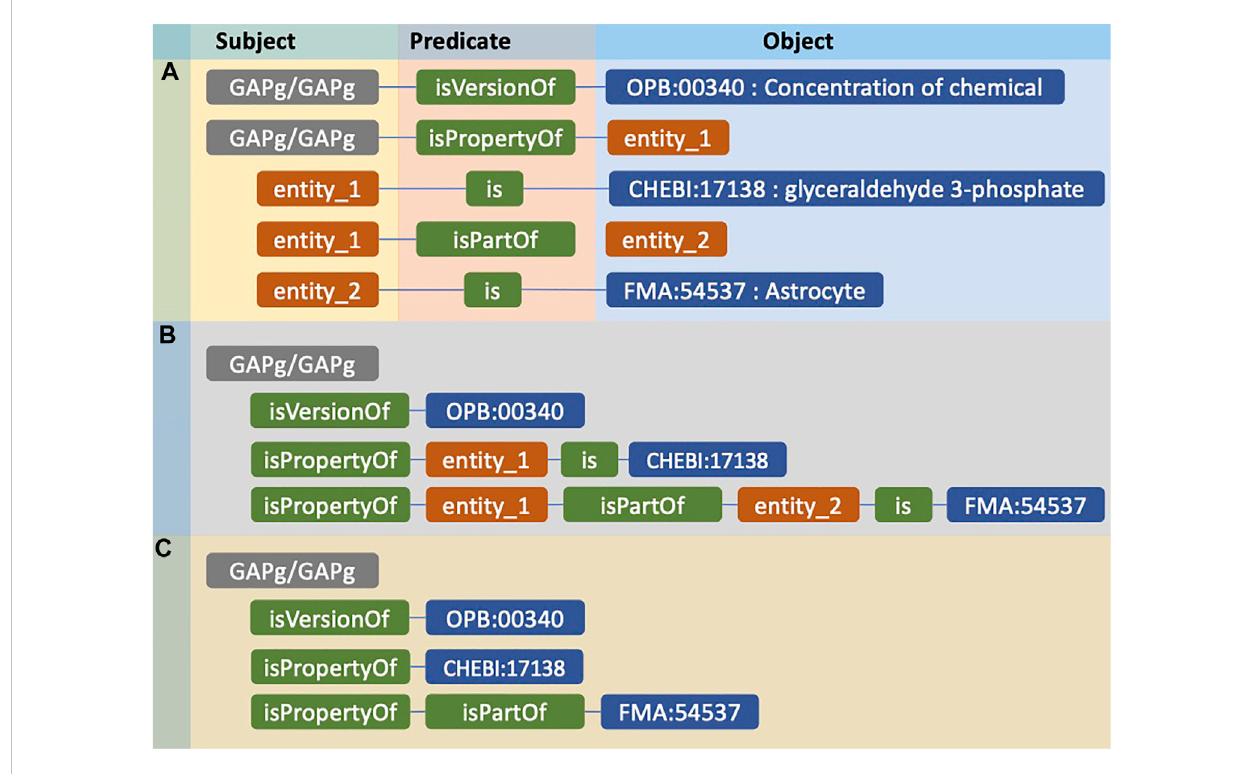
FIGURE 1 The example of an entity compositely annotated using RDF and its representation for further conversion to embedding. (A) The composite annotation of GAPg / GAPg entity by three ontology classes. (B) Paths consist of predicates connecting the entity to ontology classes. (C) The representation of the entity before converted to entity